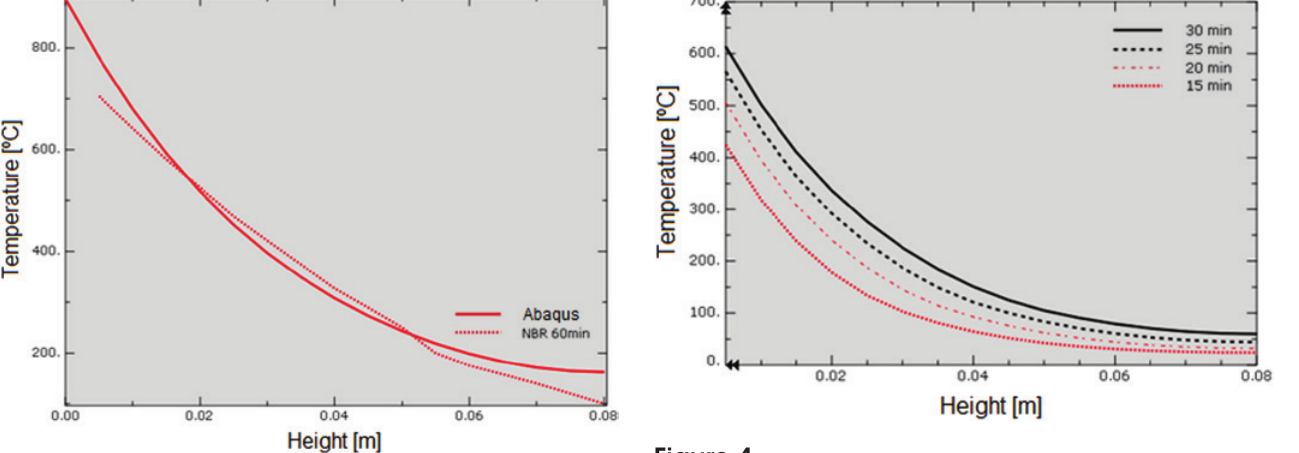
Temperature as function of the slab height, 60 minutes